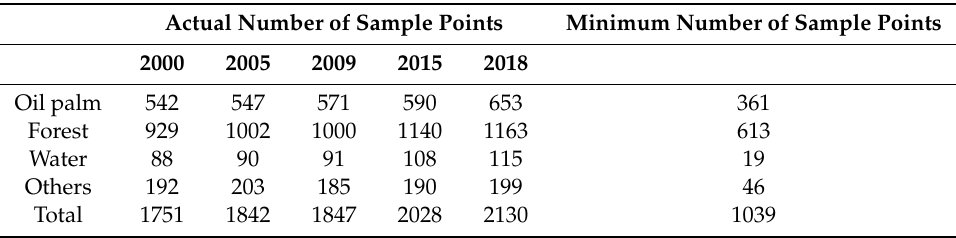
Table 1. The number of sample